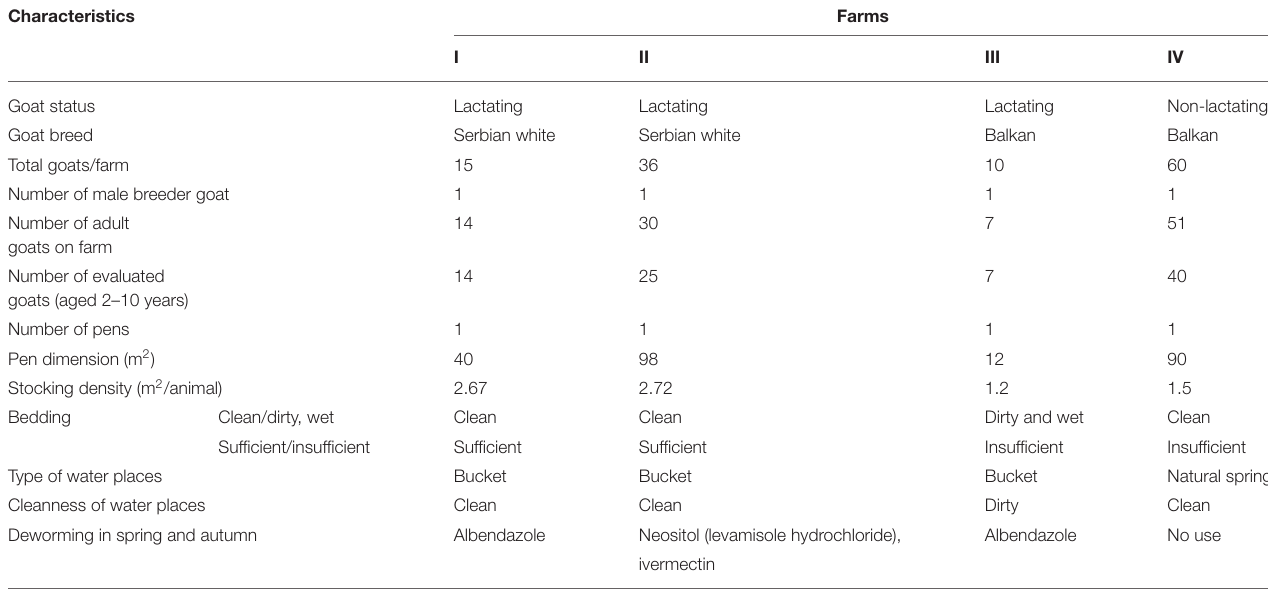
TABLE 1 | Characteristics of the examined